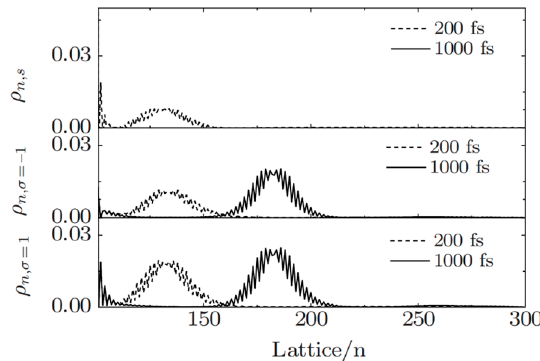
Figure 5. The distribution of spin up, spin down and net spin density in organic layer at different times, where the bias voltage was V = 0.85 eV and the electric field was E = 0.5 mV/nm. By Fu et al. [39] with the permission of Physical Review B.